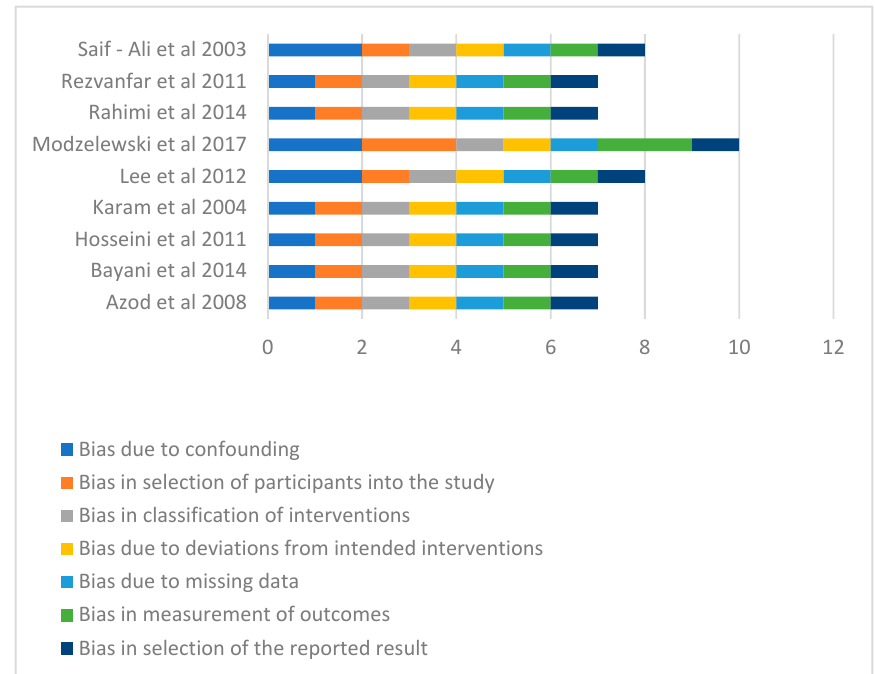
Figure 2. Summary of risk of bias (1 unit represents a low risk of bias while 2 represent moderate risk of bias).